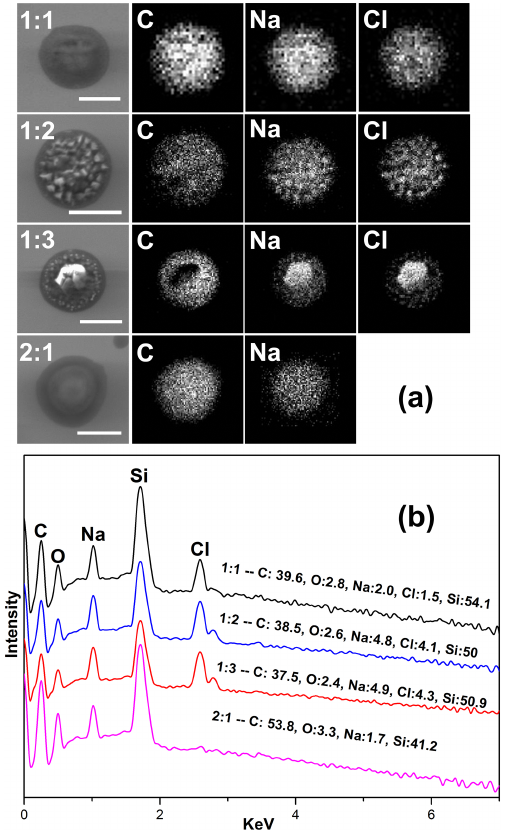
Figure 8. (a) Secondary electron images (SEIs) and elemental X- ray maps for C (from MBTCA and NaH 2 M), Na (from NaH 2 M and NaCl), and Cl (from NaCl). The scale bars are for 5µm; (b) X-ray spectra and elemental concentrations of particles with four mixing